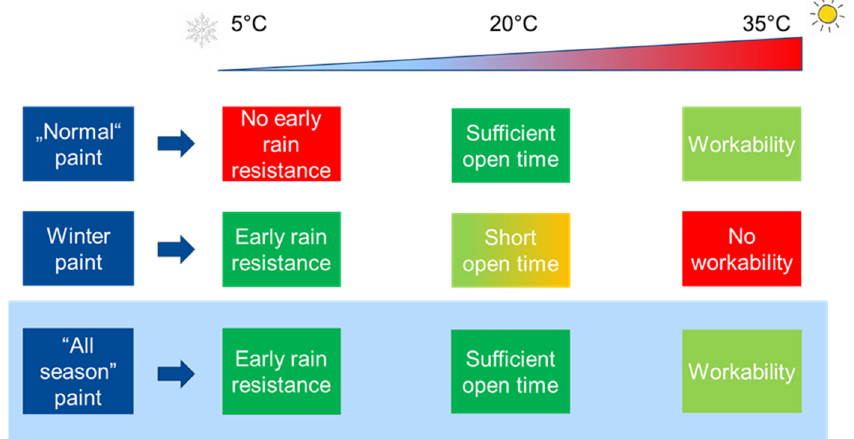
Figure 1. Criteria for all-season paints.